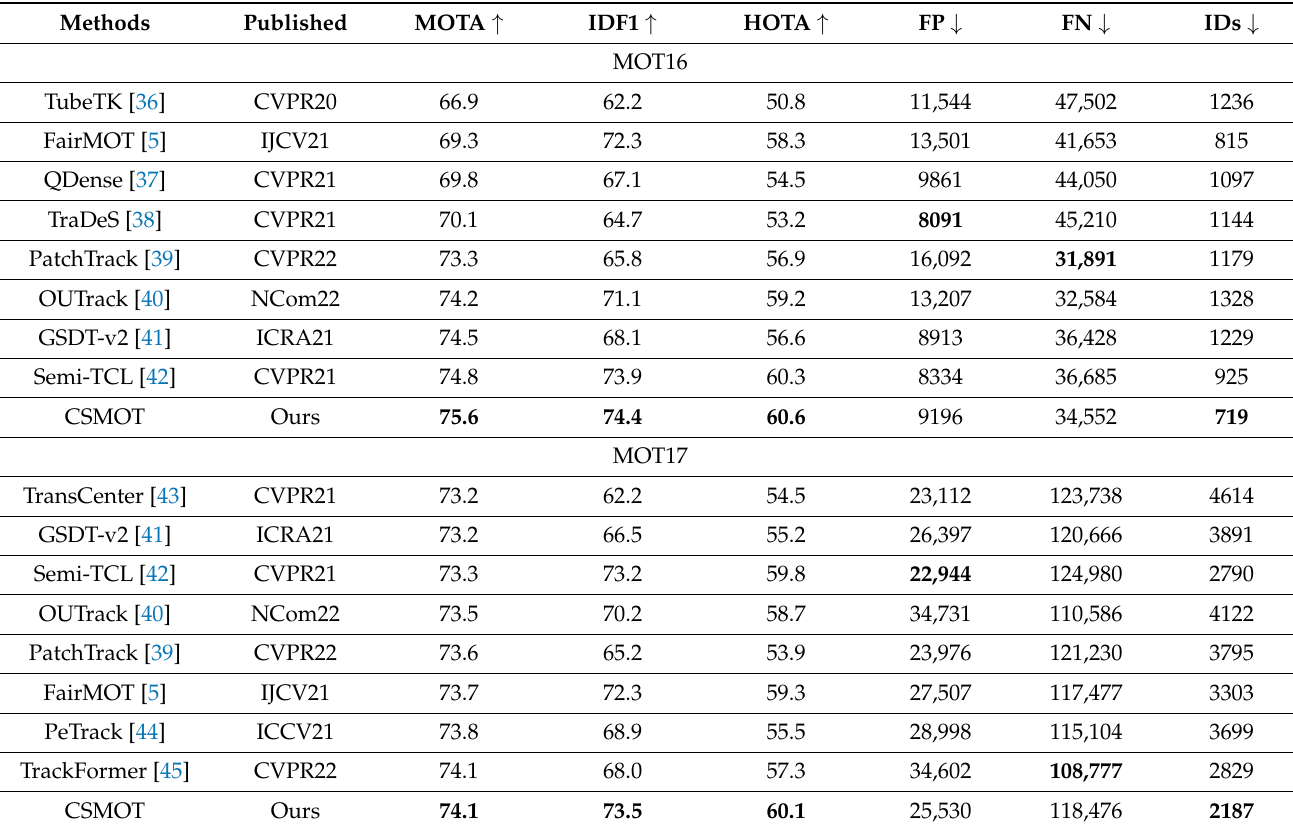
Table 8. Comparison of the state-of-the-art algorithms under the “private detector” protocol on the MOT16 and MOT17 test sets. The best results of each dataset are shown in bold